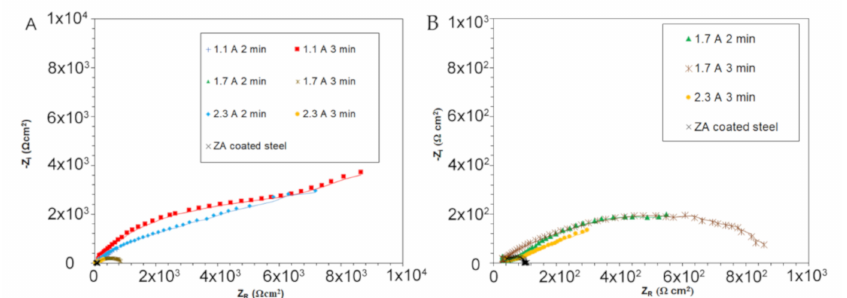
Figure 6. Nyquist plot coming from EIS tests, global results ( A ) and detail of the samples with low resistance ( B ) (test electrolyte: 0.1 M Na 2 SO 4 ). In the graphs, dots represent the experimental data, lines the result of the fitting.